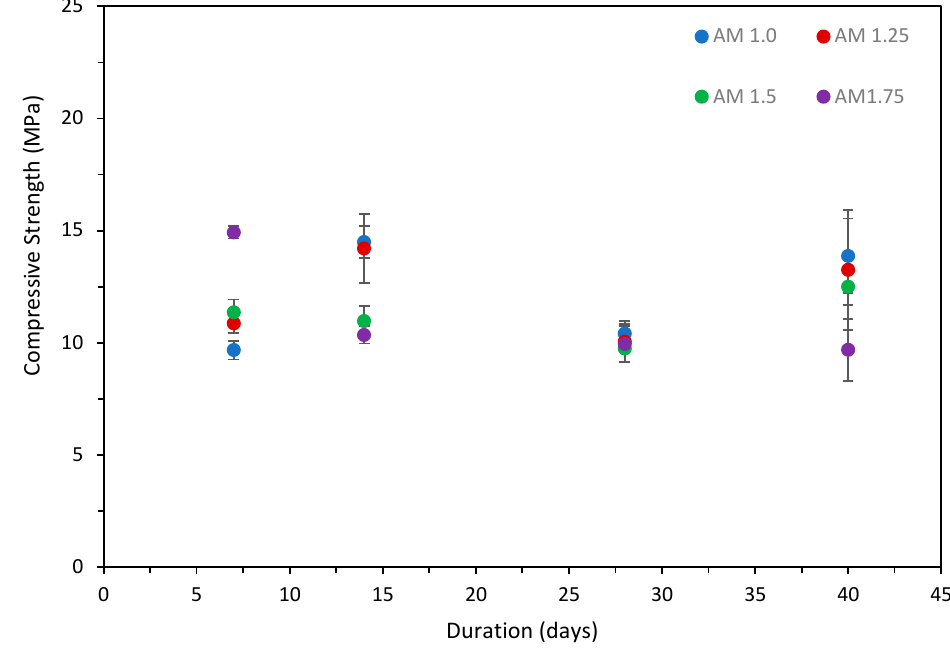
Figure 2. Compressive strength vs. time, 15% Na 2 O dosage specimens.